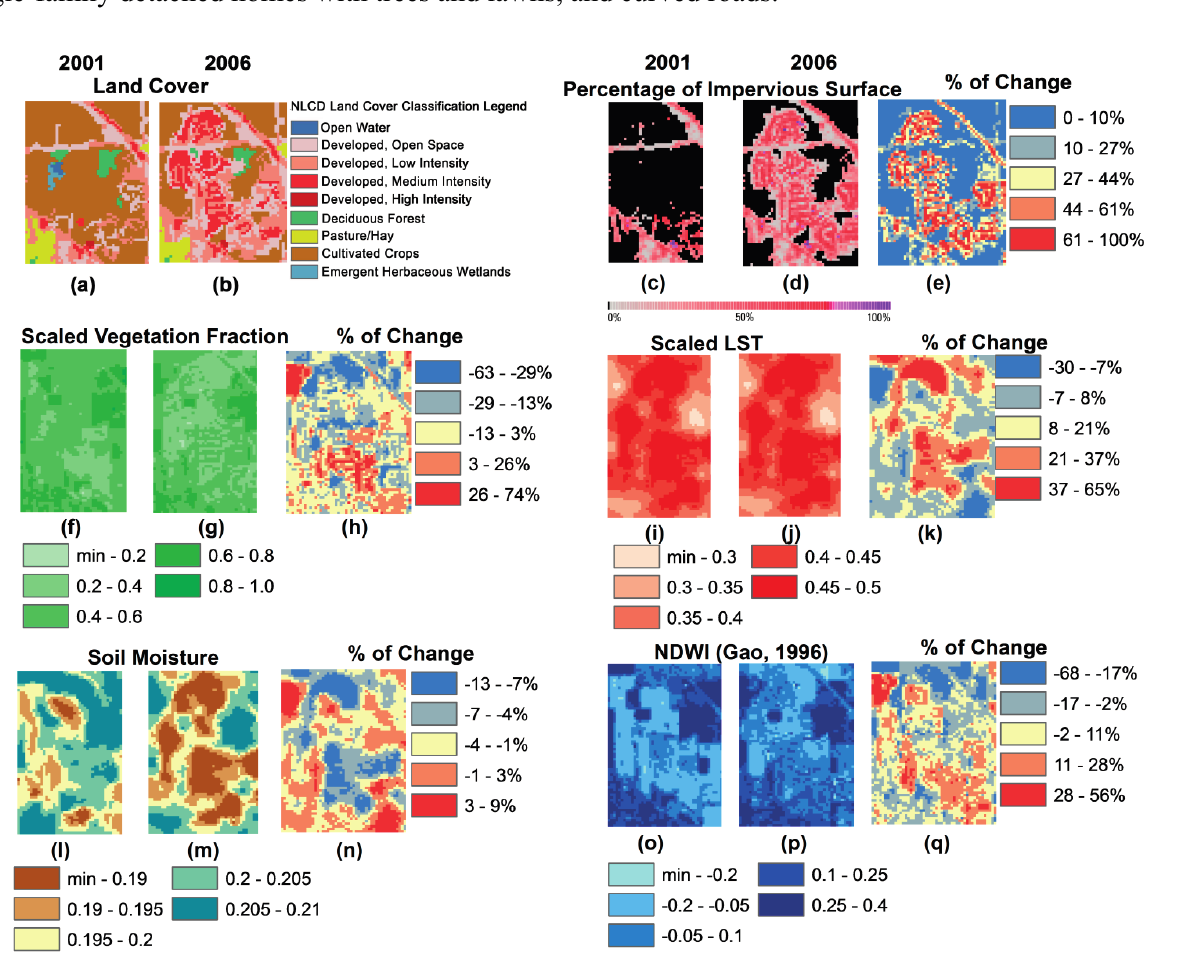
Figure 4. Land cover, the percentage of impervious surface, scaled vegetation fraction, scaled Land Surface Temperature (LST), soil moisture, and Normalized Difference Water Index (NDWI) [15] in 2001 and 2006, and the percentage of changes of each parameter from 2001 to 2006. Land cover change and percent of imperviousness were acquired from National Land Cover Database (NLCD), while other parameters were generated from this